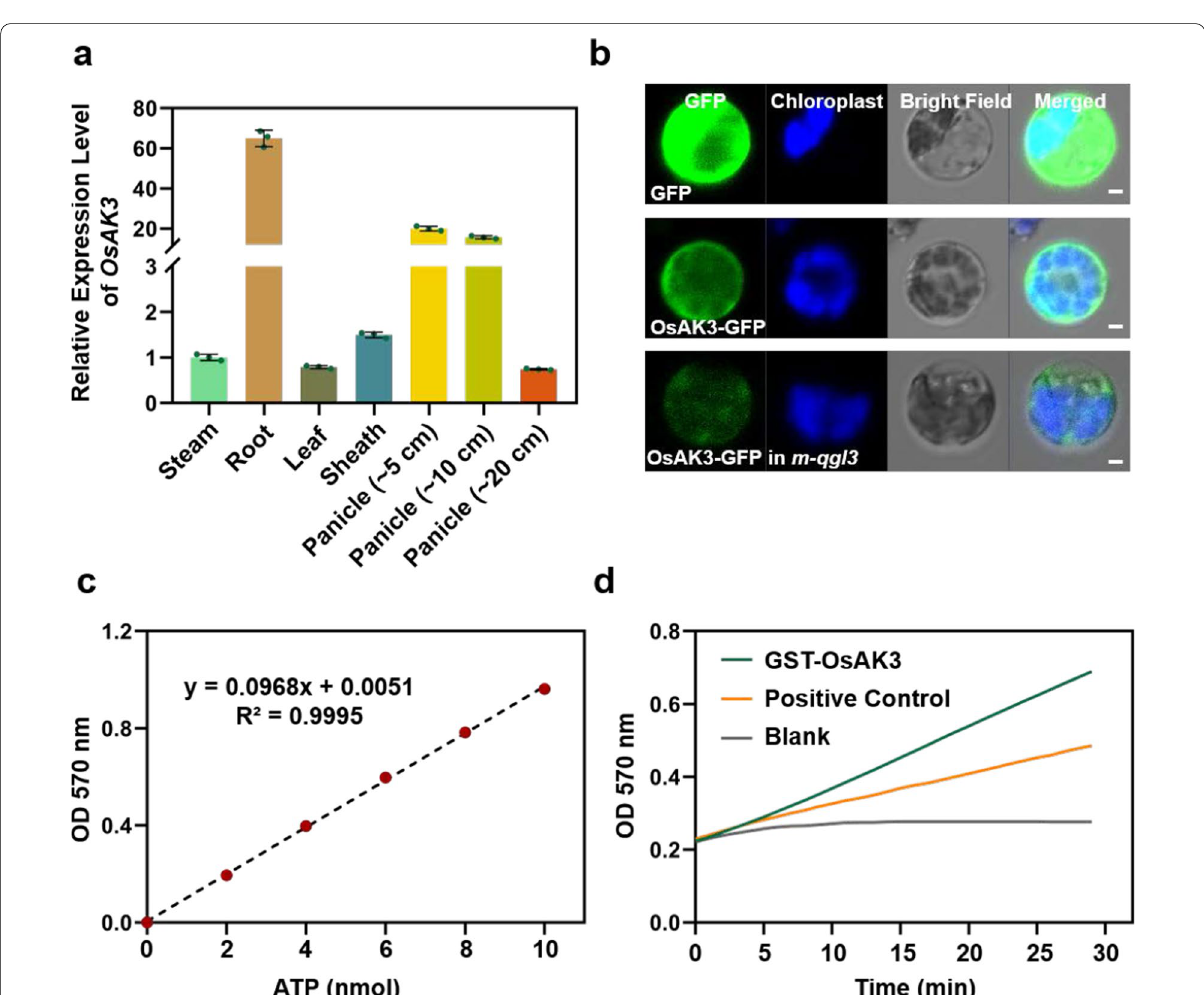
Fig. 2 OsAK3 is a functional adenylate kinase localized in cytoplasm. a RT-qPCR analysis of OsAK3 expression in various rice tissues. b Subcellular localization of OsAK3 in rice protoplast. m-qgl3 mutant was used to observe the effect of the absence of qGL3 on OsAK3 localization (scale bar, 2 μm). DJ was used as a wild type. c ATP Standard Curve. d Colorimetric quantitation of Adenylate Kinase Activity in GST-OsAK3 (0.5 ng) and Positive Control (5